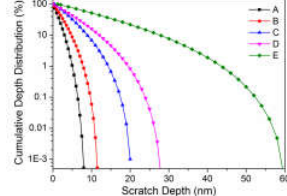
Table 2. The calculated results in all samples.